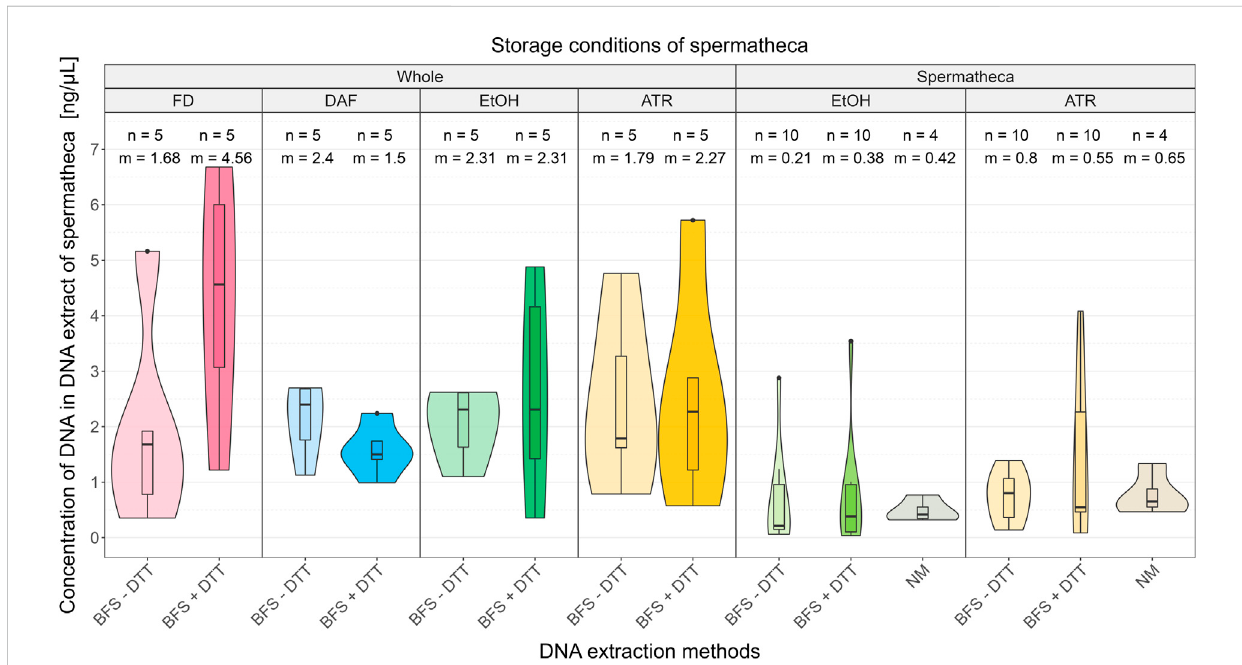
FIGURE 2 Comparison of DNA concentration in DNA extracts obtained from different storing conditions of honeybee samples and DNA extraction method withorwithoutDTTfromspermathecas.Abbreviations:ATR,AllprotectTissueReagent;EtOH,absoluteethanol;DAF,dissectedafterfreezing;FD,freshly dissected;BFS,QIAampprotocol “ IsolationofTotalDNAfromBodyFluidStains ” ;+DTT,withdithiothreitol; − DTT,withoutdithiothreitol;NM,NucleoMag Tissue Kit ’ s protocol; n, sample size; m,